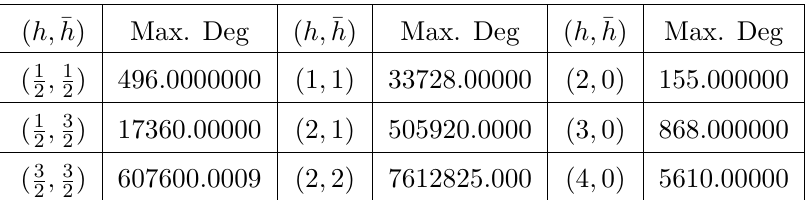
Table 12. The maximum value of degeneracies for low-lying states in putative CFT with c = 8, without the spin-1 conserved current. The maximum number of derivatives is set to N max = 55, while the spin is truncated at j max =